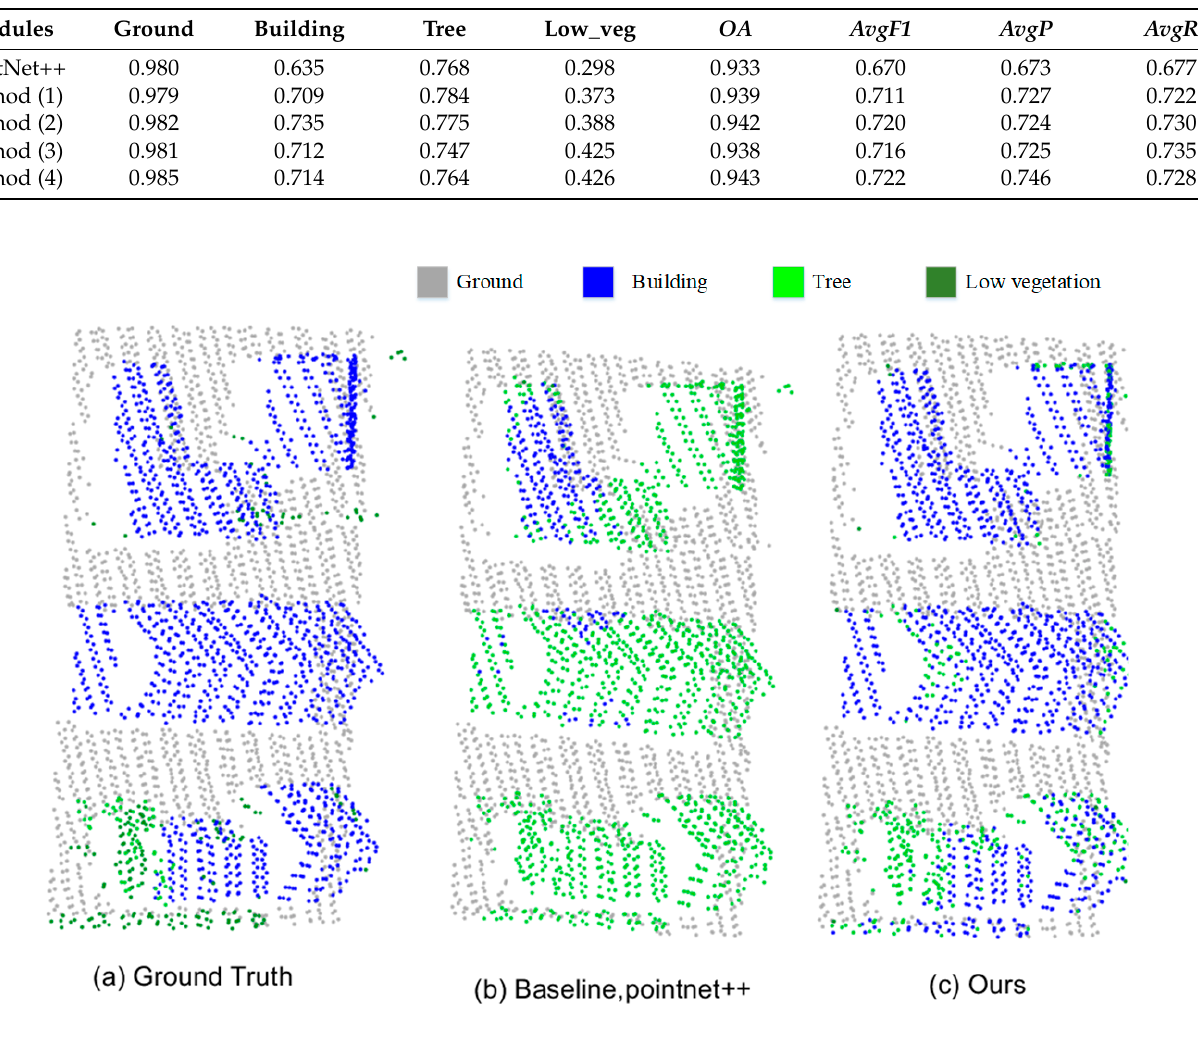
Figure 7. The classification results of the PointNet++ and our proposed method in a selected